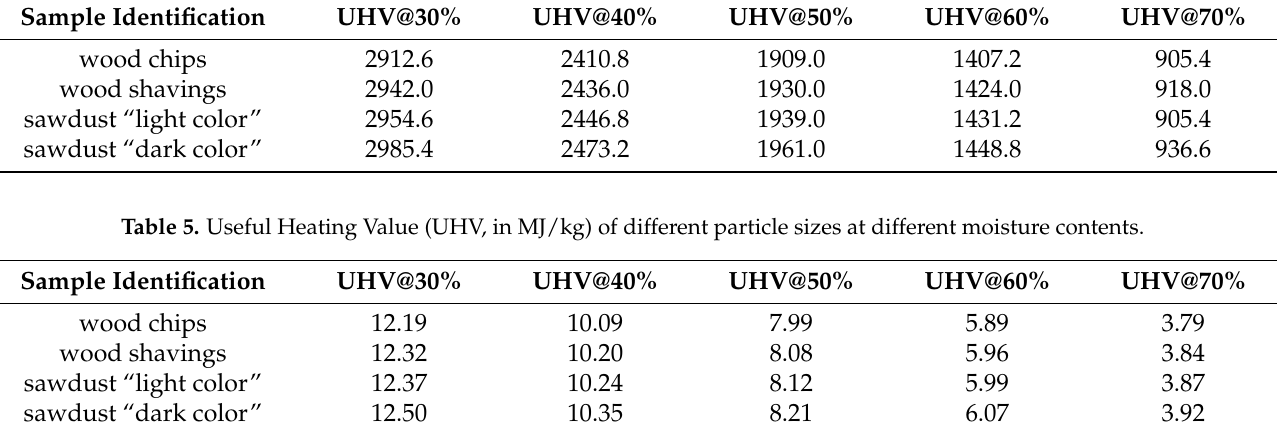
Table 4. Useful Heating Value (UHV, in kcal/kg) of different particle sizes at different moisture contents. Sample Identification